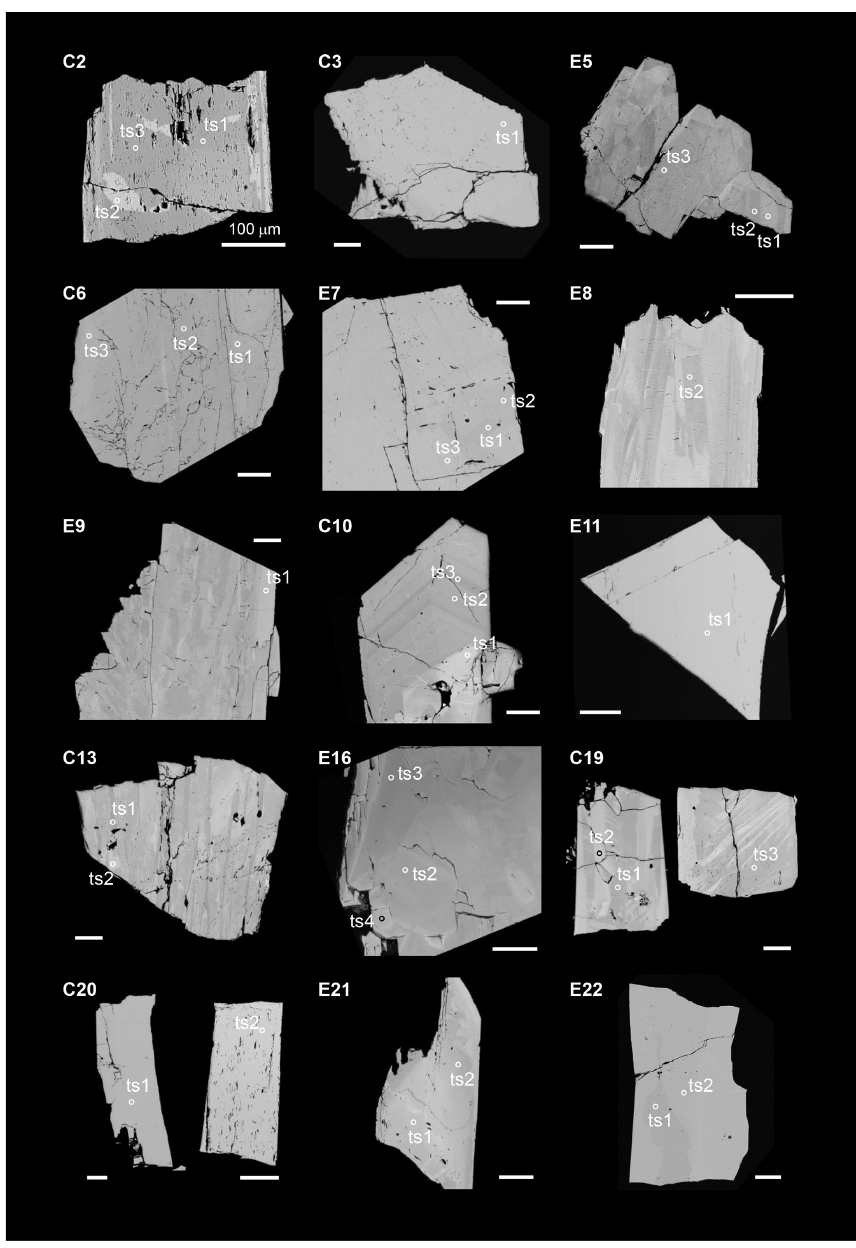
Figure 2. Backscattered electron (BSE) images of the studied specimens. Circles mark the areas analysed by EPMA and Raman spectroscopy; note that for better visualization the diameter of the circles is considerably larger than the true size of the corresponding analytical point. The sample orientation is the same as the orientation in which the Raman spectrum was collected. Scale bars are